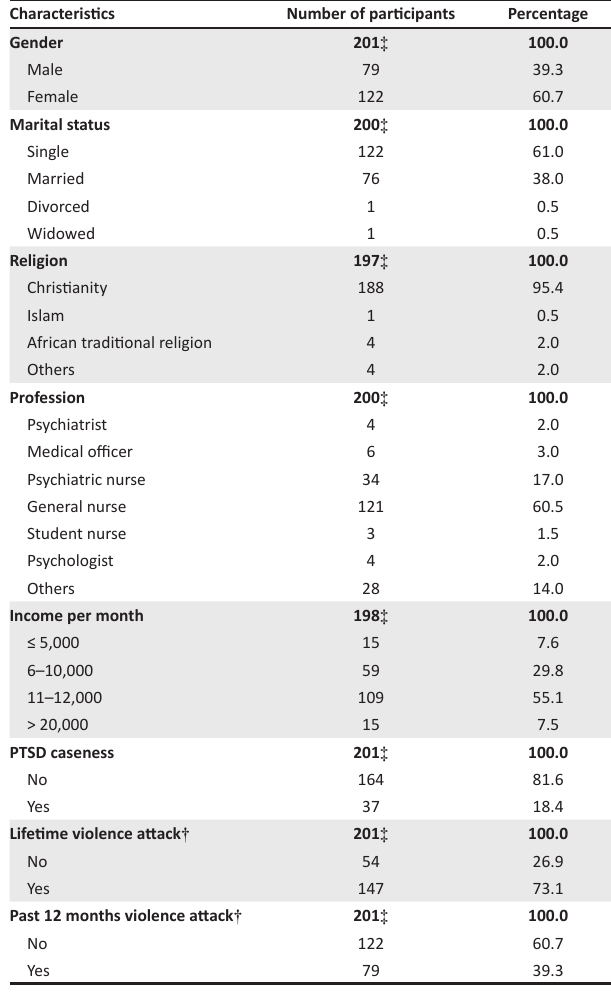
TABLE 1: Socio-demographic characteristics of the participants.